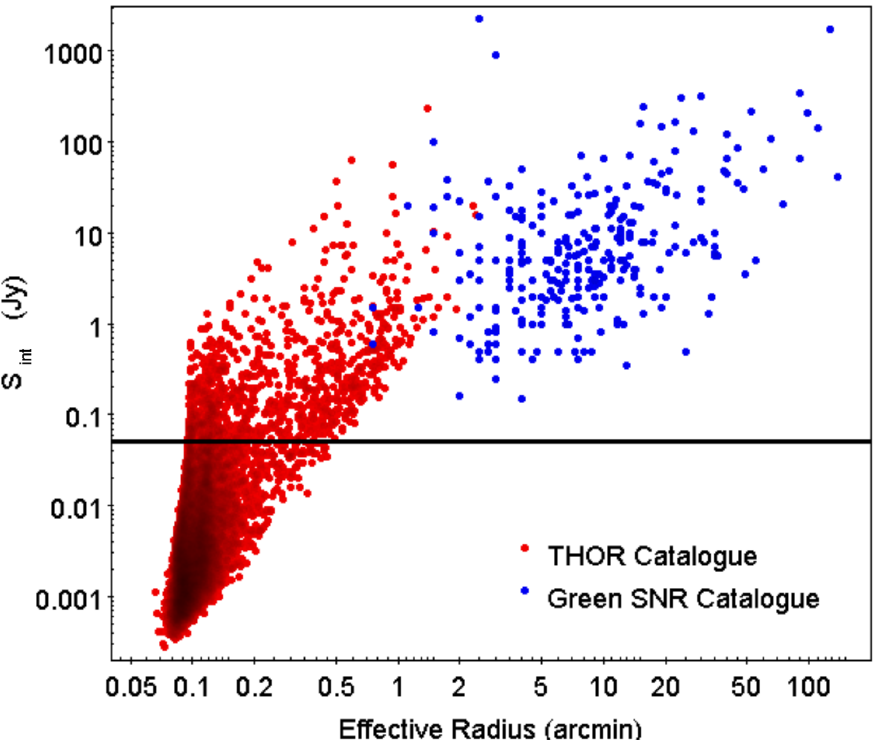
Figure 9. Distribution of integrated flux densities at 1.4 GHz of sources from the catalogue of [22] (red) and Green’s SNR catalogue (blue). Sources above 50 mJy (horizontal line) were chosen to obtain HI